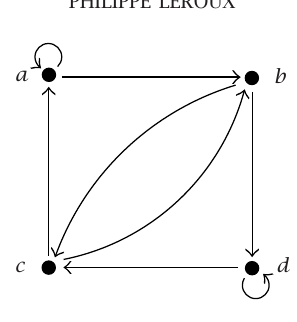
Figure 3.1 . Directed graph associated with Sl q ( 2 )